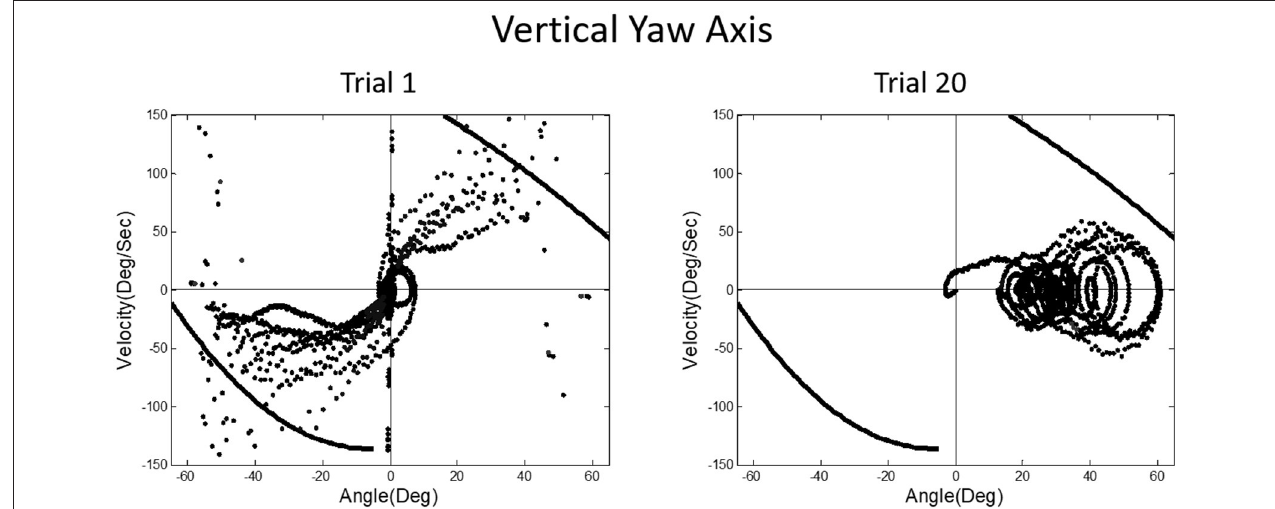
FIGURE 13 | Velocity-position phase plots for vertical yaw axis balancing. The drifting and looping and crashes characteristic of horizontal roll plane balancing ( Figure 12 ) are apparent for the yaw axis, where there are also no gravity dependent positional cues available about ongoing yaw rotational position. Subjects, as in horizontal roll, report being unable to sense their ongoing position relative to the direction of balance.